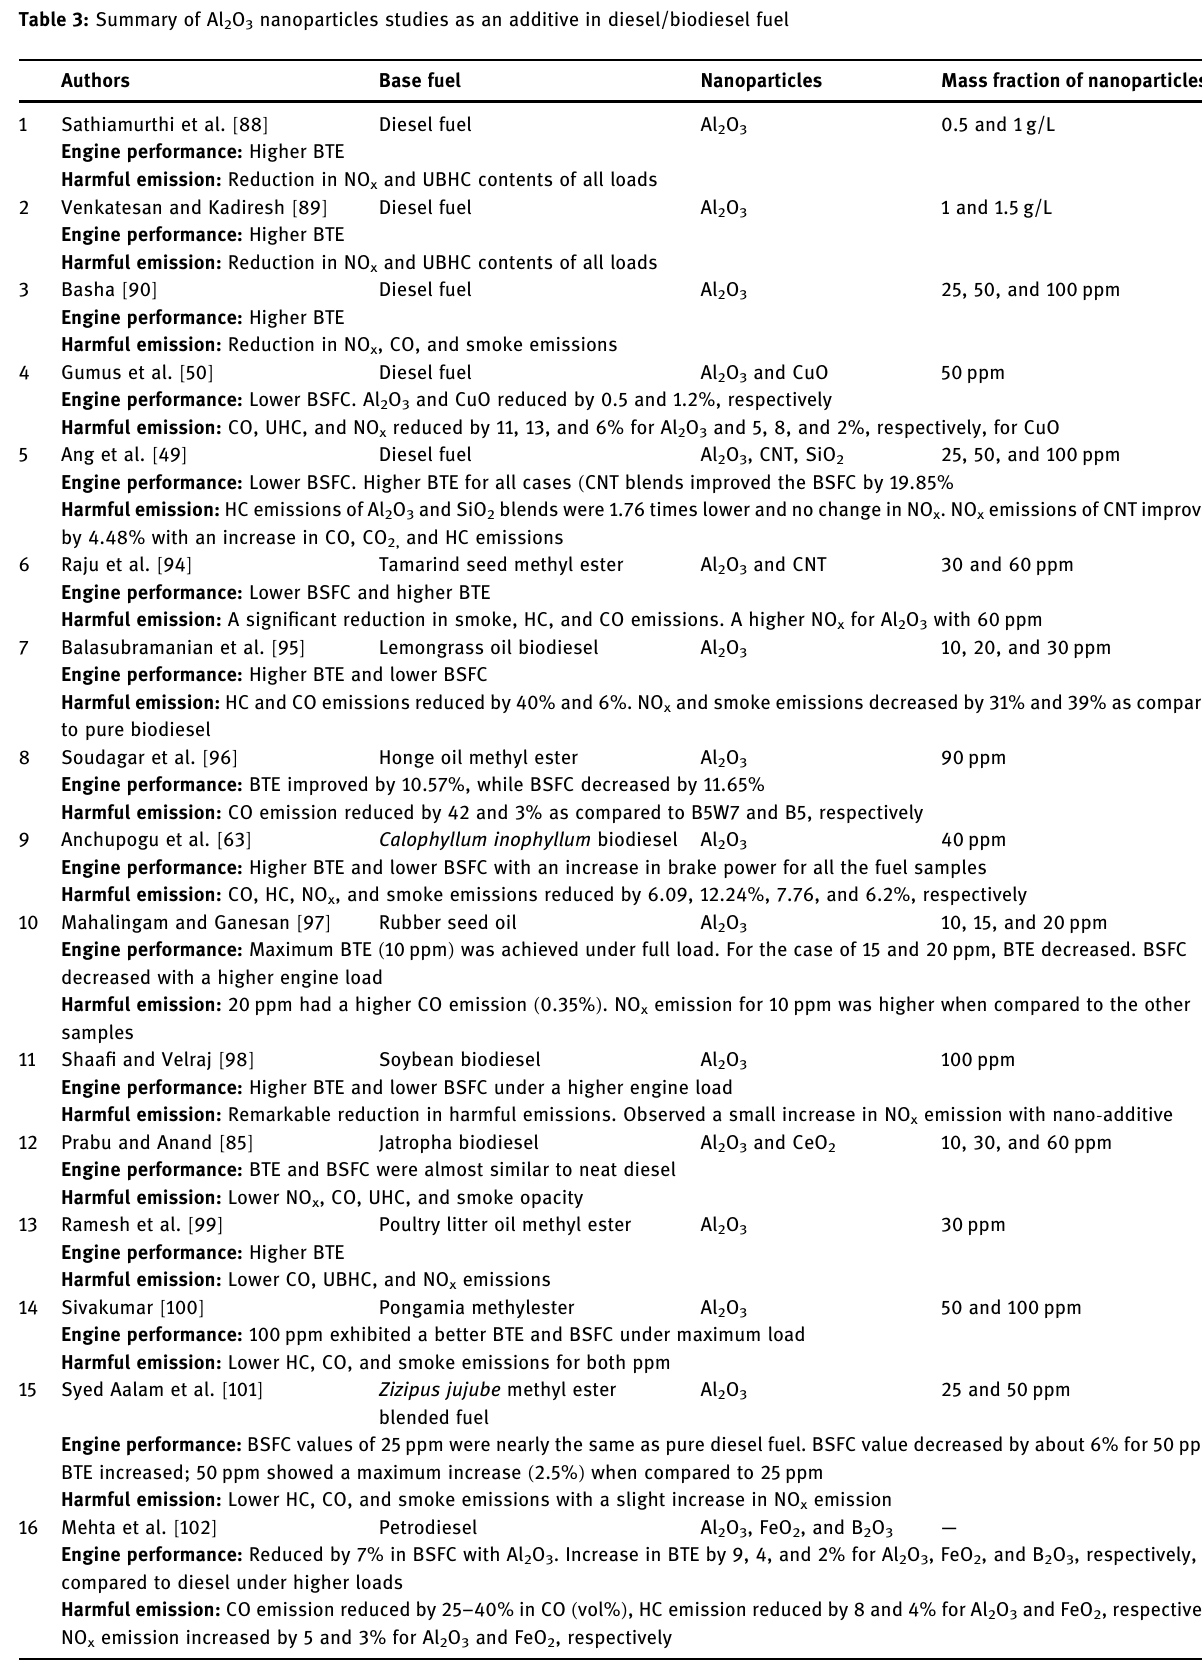
Table 3: Summary of Al 2 O 3 nanoparticles studies as an additive in diesel/biodiesel fuel